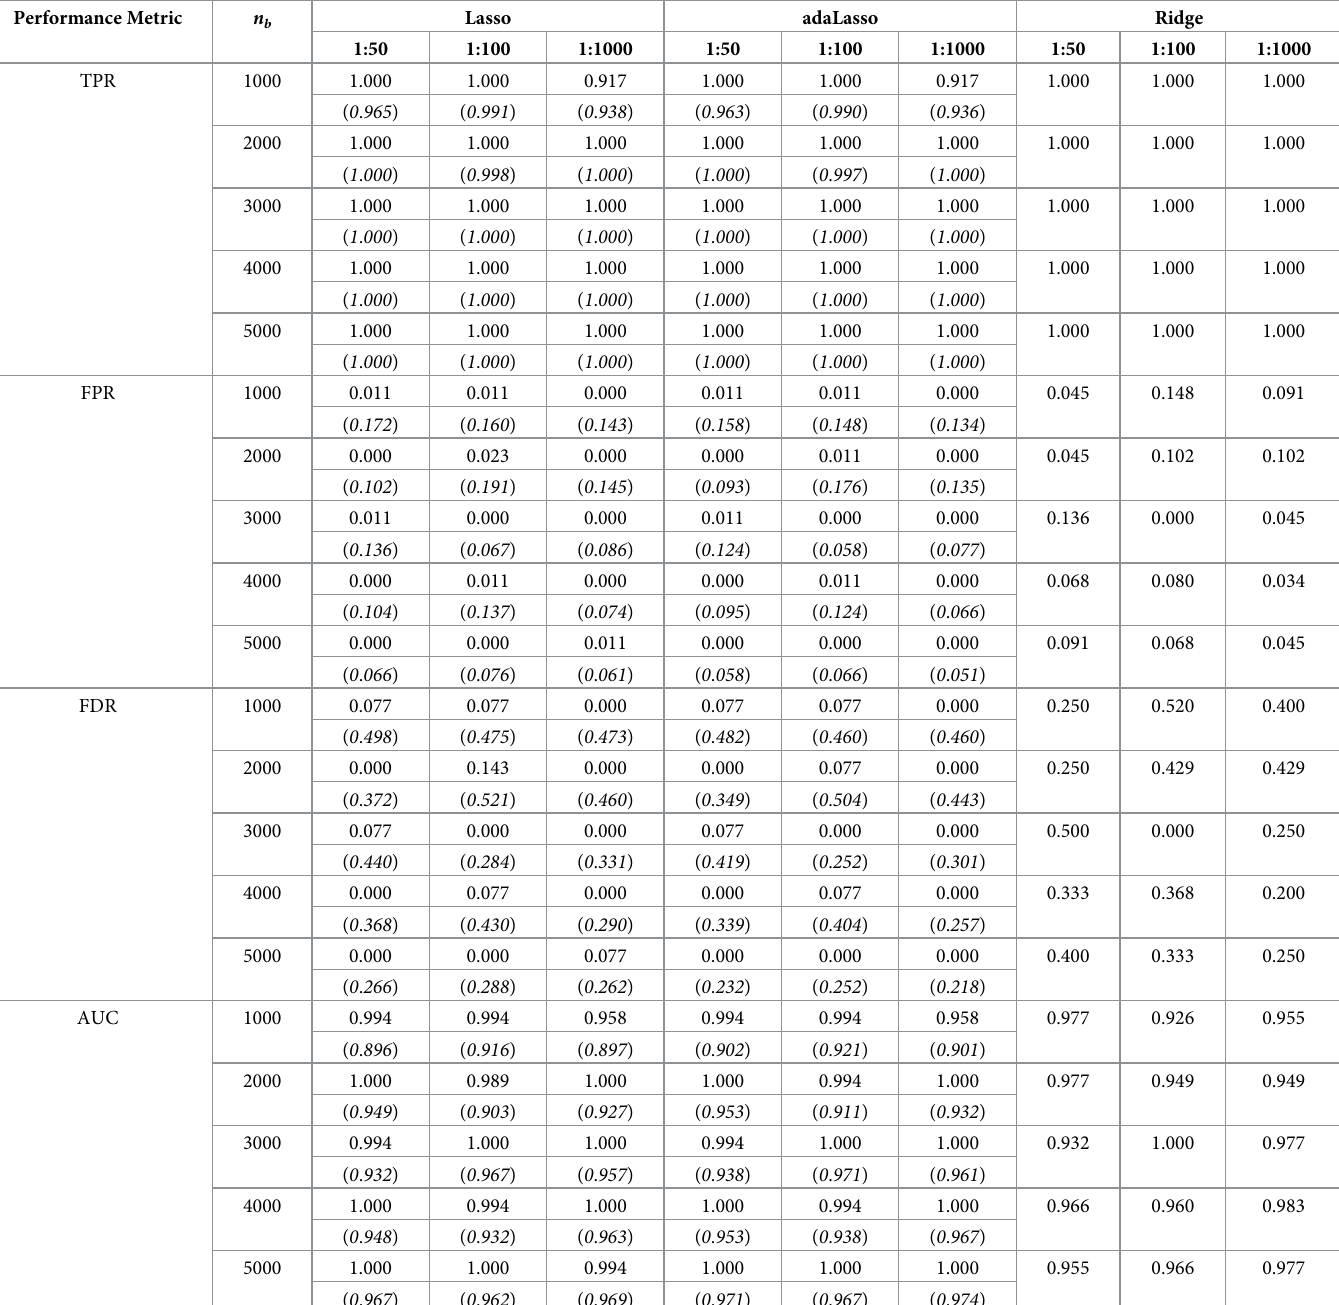
Table 3. Simulation under UNCOR-12. Performance metric scores for variable selection based on the SVRS algorithm and average scores (reported in parenthesis) across 500 individual fits of each regularization model with imbalance ratios 1:50, 1:100 and 1:1000. Performance scores for individual ridge regression fits are not applica- ble as it does not perform automatic variable